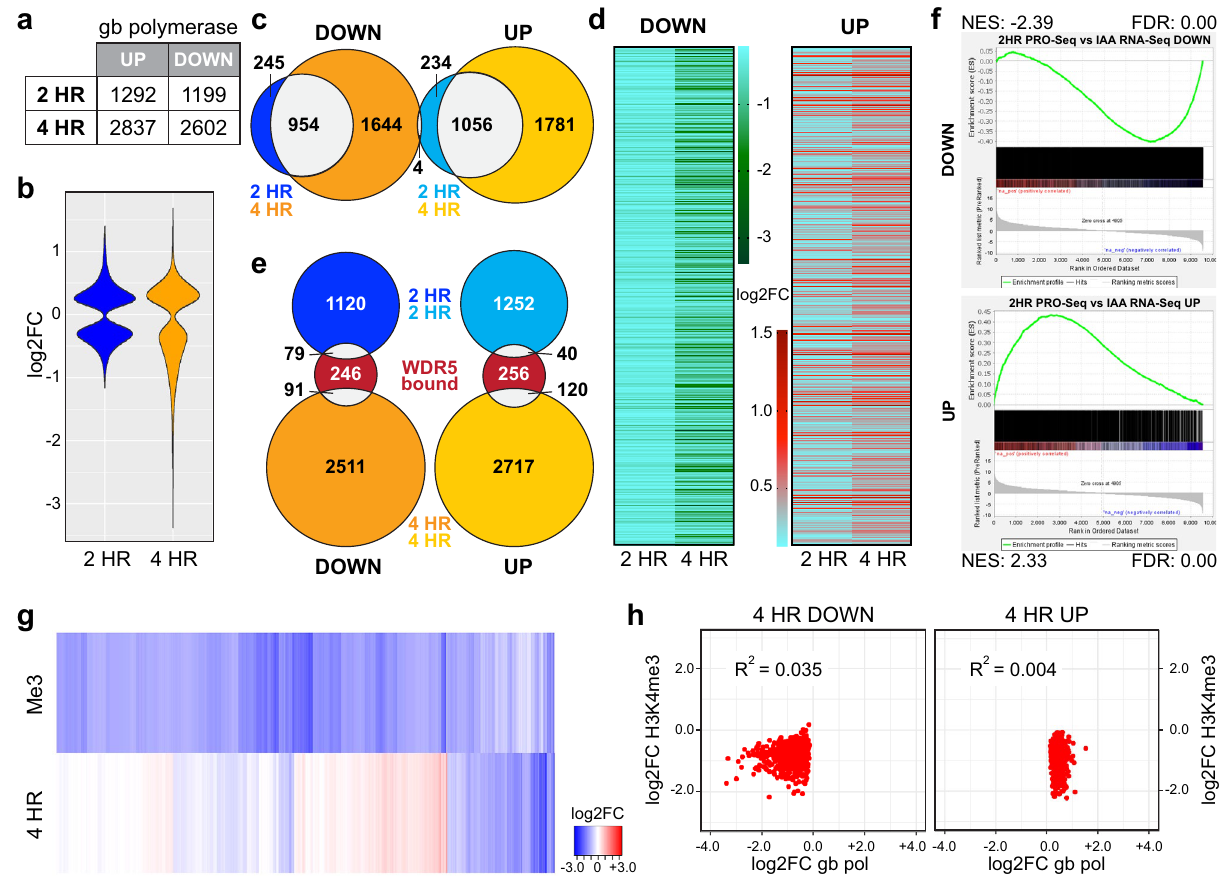
Figure 4. Rapid impact of WDR5 loss on transcription. ( a ) Summary of PRO-Seq from AIDW cells treated with 100 μM IAA for 2 or 4 h. Table shows the number of genes that had a significant increase or decrease in gene body (gb)-associated RNA polymerases at the 2 and 4 h timepoints (FDR < 0.05). N = 3. ( b ) Violin plot, displaying the magnitude of all significant transcription changes associated with 2 or 4 h of IAA treatment, plotted as log2FC. ( c ) Venn diagram, showing overlap of genes in the 2 and 4 h IAA treatment sets with significant changes in gb-associated polymerases, according to whether gb-polymerase density decreased (DOWN) or increased (UP) with IAA treatment. ( d ) Heatmaps, showing log2FC values for genes with decreased or increased gb-associated polymerases in the 2 and 4 h IAA treatments. ( e ) Venn diagram, showing the overlap of genes with significant changes in gb-associated polymerases with those bound by WDR5 in Ramos cells 4 , broken down according to whether gb-polymerase density decreased (DOWN) or increased (UP) with IAA treatment. ( f ) GSEA showing the enrichment of genes with significant decreases (top) or increases (bottom) in transcript changes detected in IAA RNA-Seq against gb-associated polymerases following 2 h of IAA treatment (PRO-Seq). NES normalized enrichment score, FDR false discovery rate. ( g ) Heatmap, showing log2FC values for genes changed in either gb-associated polymerases in 4 h IAA treatments (PRO-Seq) or H3K4me3 (me3) levels in IAA-treated cells. ( h ) Scatter plots, comparing log2FC in H3K4me3 induced by WDR5 degradation with log2FC in gb-associated polymerases induced by WDR5 degradation after 4 h (4 HR) of IAA treatment. The plot on the left shows genes with decreased polymerase density; the plot on the right shows genes with increased polymerase density. The coefficient of determination (R 2 ) is